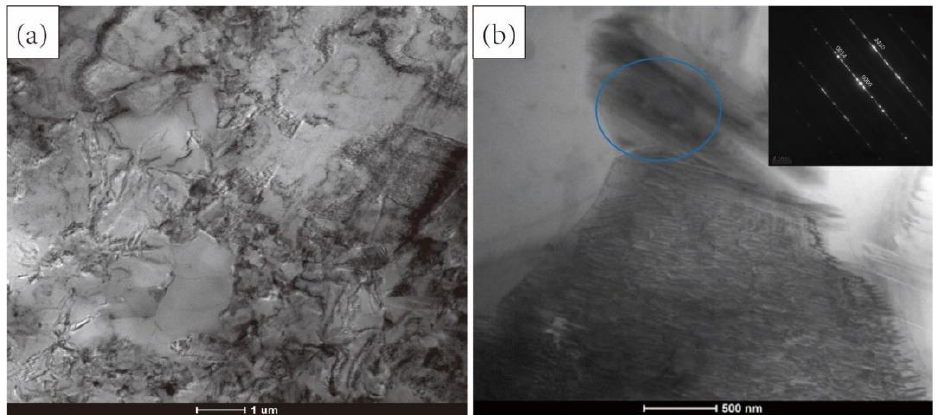
Figure 6. ( a ) TEM images of electrically assisted sample (26.58 A∙mm −2 ); ( b ) the corresponding selected area electron diffraction (SAED) of the area marked circle.